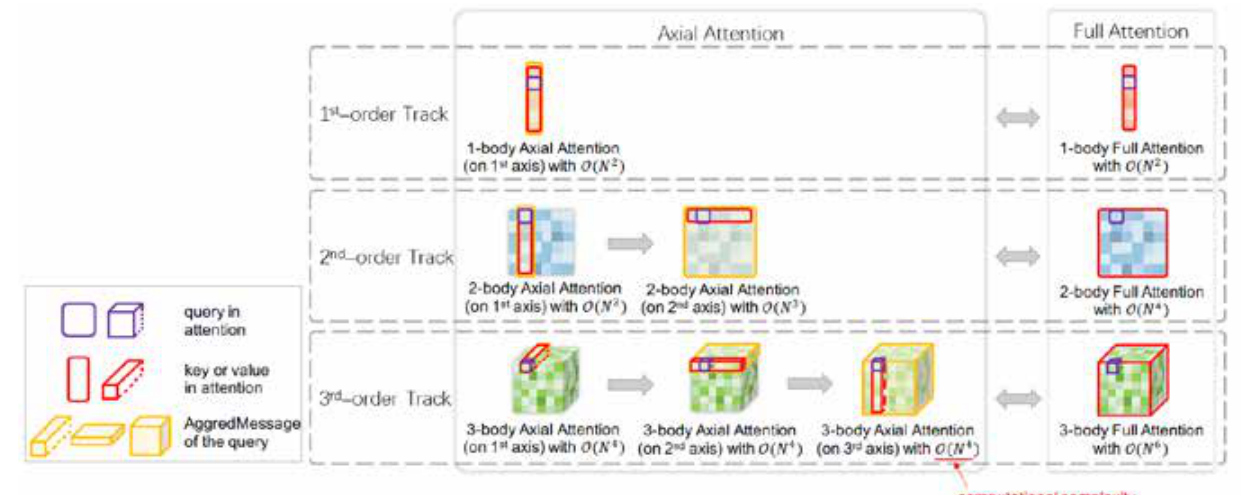
Figure 8 Principle of many-body axial attention